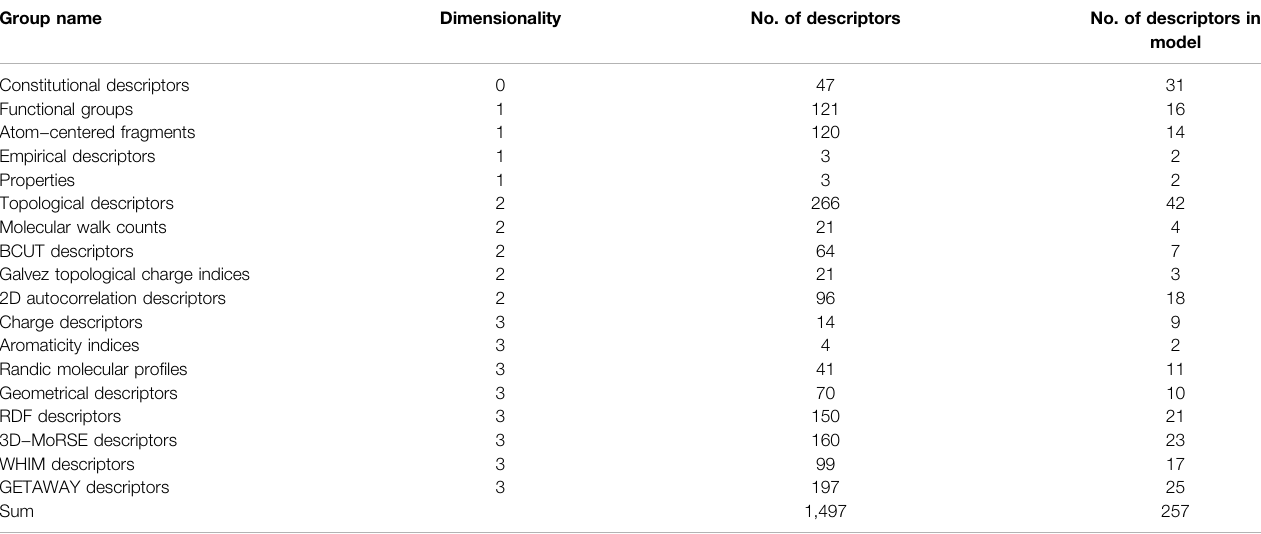
TABLE 2 | List of molecular descriptors that created by Dragon